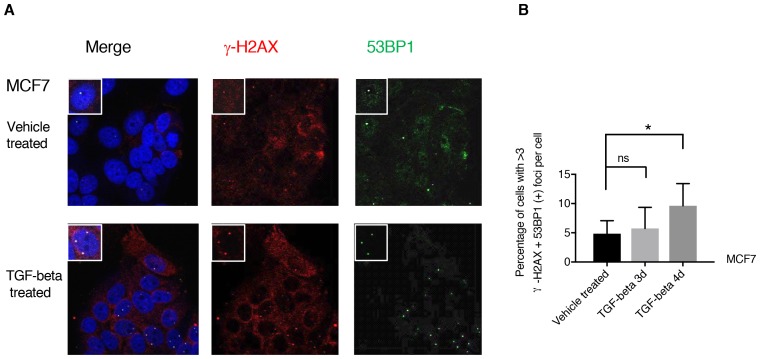
TGF-β treatment increases the number of 53BP1/γ-H2AX double-positive foci in MCF7 cells.(A) MCF7 cells treated with TGF-β (1 ng/ml each of TGF-β1 and TGF-β2) or DMSO for 3 days and 4 days were stained with antibodies against γ-H2AX (red) and 53BP1 (green). DAPI (blue) was used as a counter-stain. Insets in the left upper corner show a representative nucleus. (B) The chart represents quantification of the experiment depicted in (A). Each bar represents the mean ± SD of the percentage of cells with more than threeγ-H2AX and 53BP1 double-positive foci per field in vehicle or TGF-β-treated cells. Approximately ten fields were counted, for a total of 100 cells (n = 100). (p-value *<0.005, paired t-test).